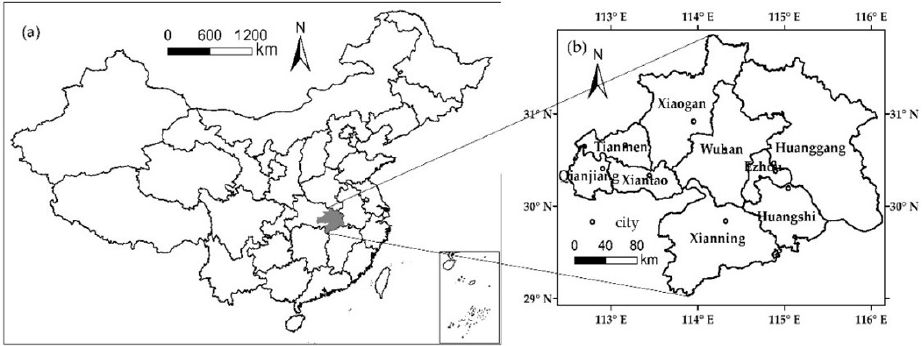
Figure 1. Location of study area: ( a ) geographic location in China; ( b ) Wuhan urban agglomeration.